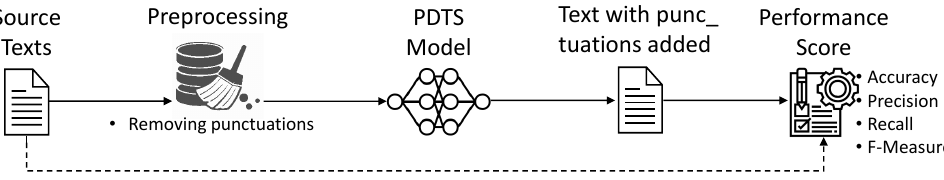
Figure 2. Description of our quantitative evaluation protocol.